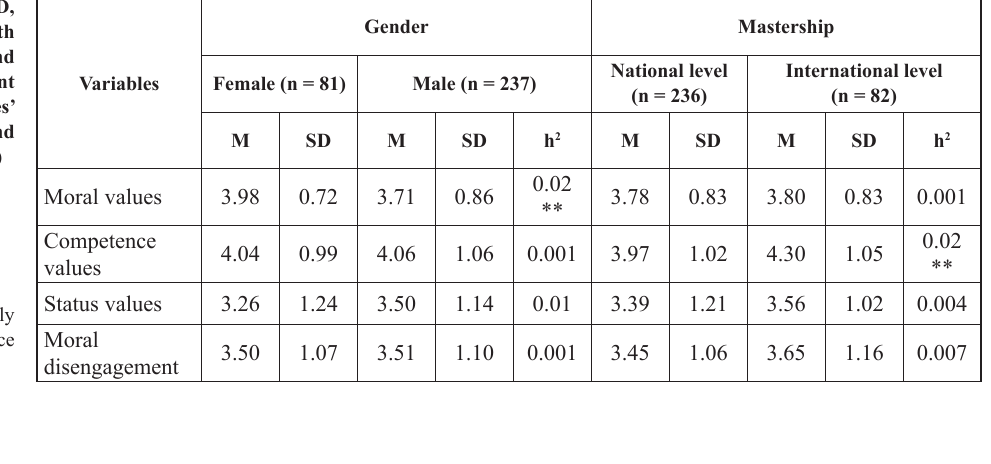
Table 3. Means, SD, and effect size of youth sport values and moral disengagement in sport by the year of involvement in sport (n = 318) Note. * – statistically significant difference (p < 0.05). ** – statistically significant difference (p <